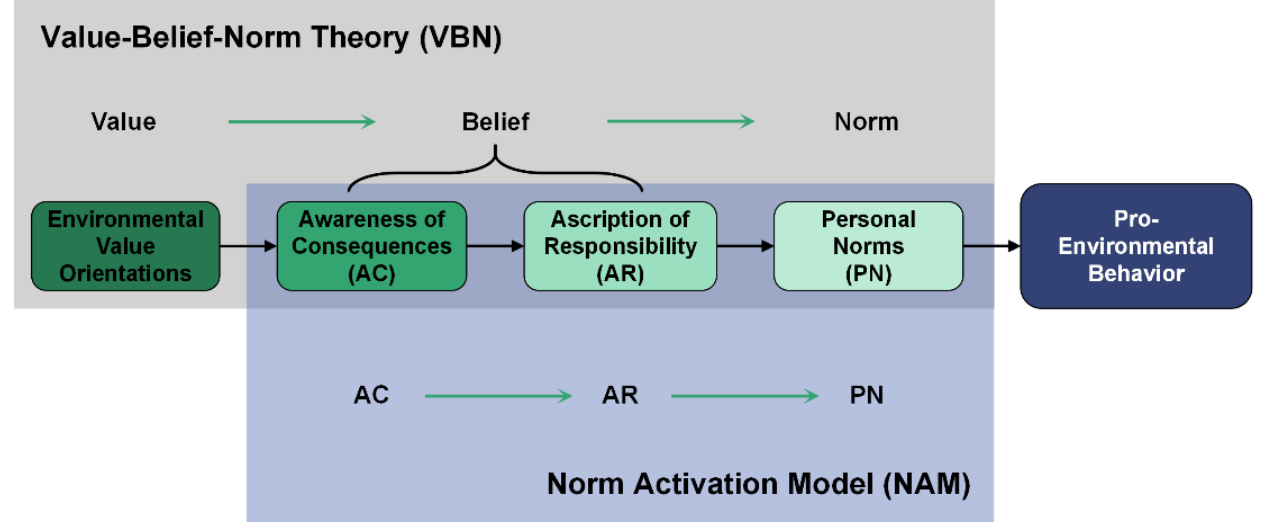
Figure 1. Research theoretical framework based on VBN and NAM